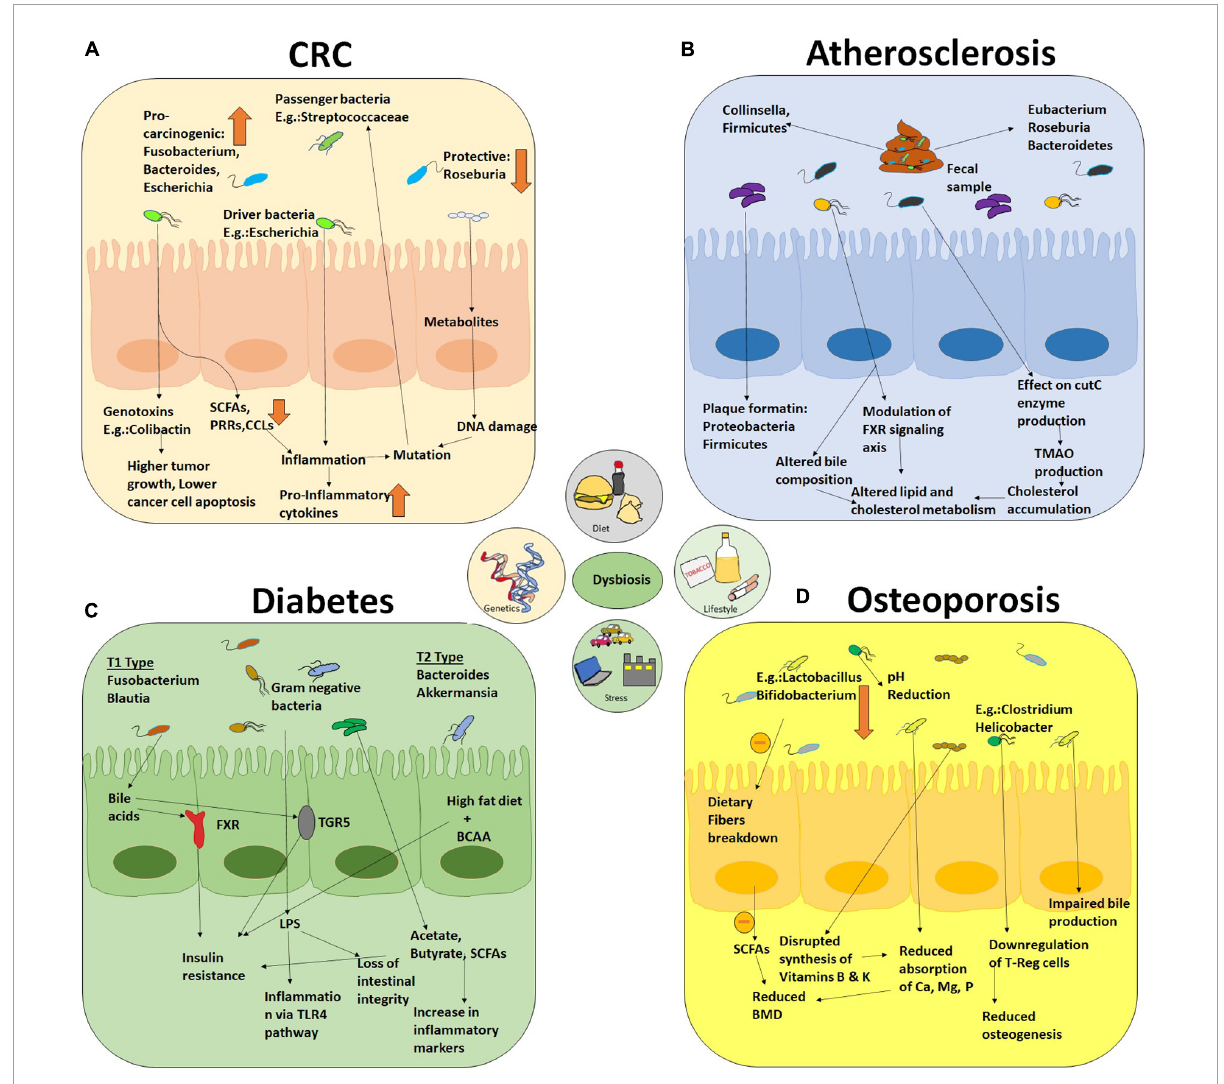
FIGURE3 An overall holistic view of the workings of dysbiotic microbiota that contribute to disease pathophysiology of NCDs and some cancers. The figure includes four major diseases (A) colorectal cancer, (B) atherosclerosis, (C) diabetes, and (D) osteoporosis as examples of the detrimental effects produced by dysbiosis in diseased